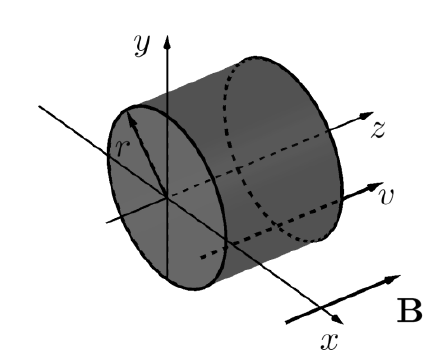
Fig. 1. The geometry of the system: the cylindrical electron beam ejected from the plane z=0 is transported in the longitudinal magnetic field B cross the z axis.